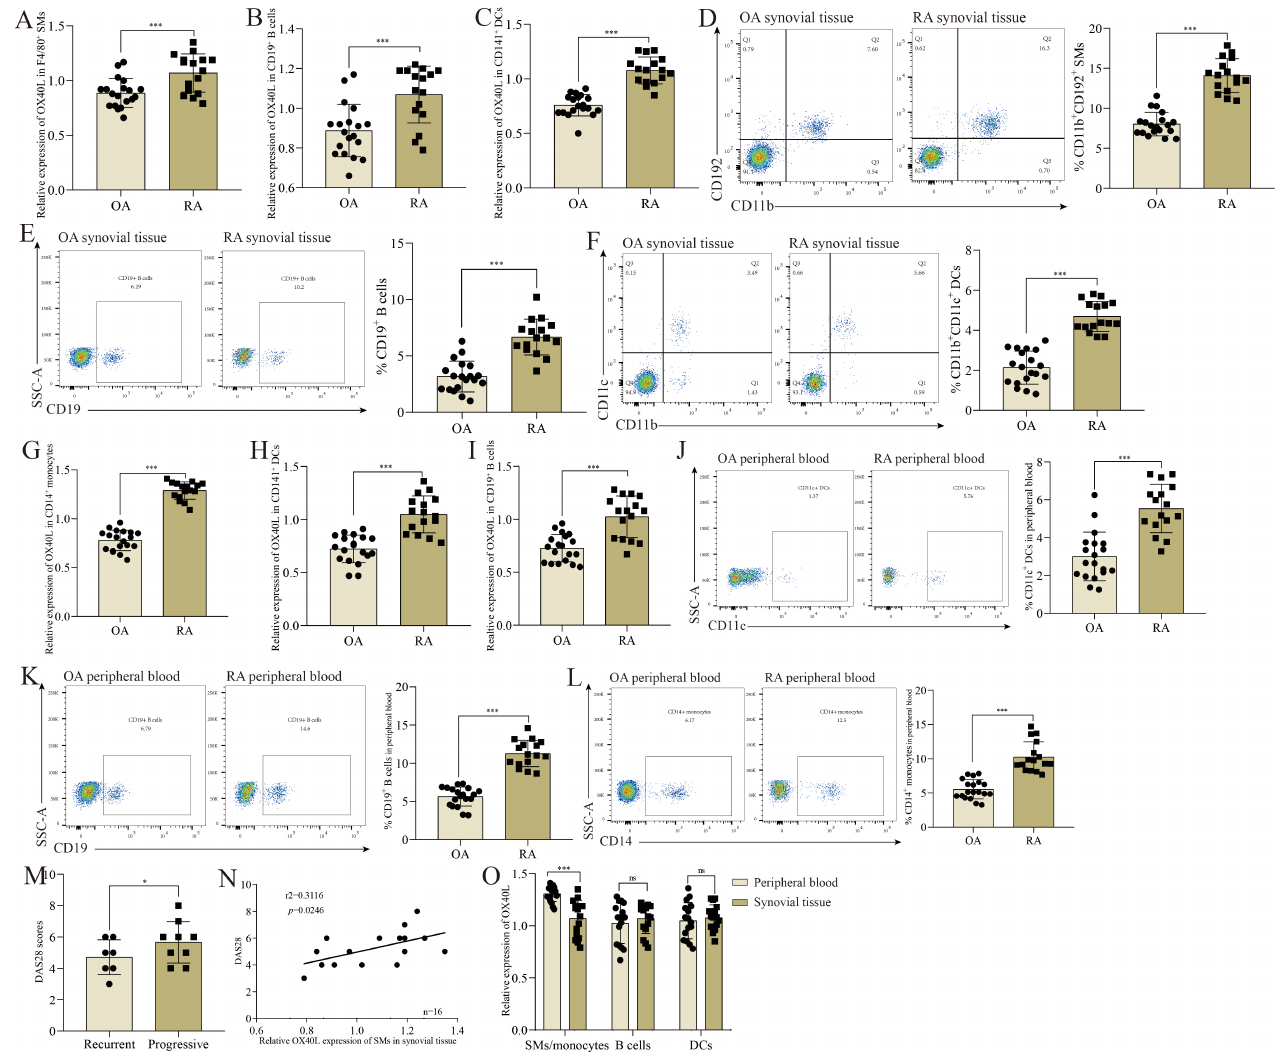
Figure 1. OX40L is up-regulated in antigen-presenting cells in the synovial tissues of RA patients, and the OX40L level in CD11b + CD192 + SMs is positively correlated with DAS28. ( A ) RT-qPCR analysis of the relative expression of OX40L in F4/80 + SMs sorted from synovial tissue. ( B ) RT-qPCR analysis of the relative expression of OX40L in CD19 + B cells sorted from synovial tissue. ( C ) RT-qPCR analysis of the relative expression of OX40L in CD141 + DCs sorted from synovial tissue. ( D ) Frequency of CD11b + CD192 + SMs in the synovial tissues of the patients with RA and the patients with OA. ( E ) Frequency of CD19 + B cells in the synovial tissues of the patients with RA and the patients with OA. ( F ) Frequency of CD11b + CD11c + DCs in the synovial tissues of the patients with RA and the patients with OA. ( G ) RT-qPCR analysis of the relative expression of OX40L in CD14 + monocytes sorted from peripheral blood. ( H ) RT-qPCR analysis of the relative expression of OX40L in CD141 + DCs sorted from peripheral blood. ( I ) RT-qPCR analysis of the relative expression of OX40L in CD19 + B cells sorted from peripheral blood. ( J ) Frequency of CD11c + DCs in the peripheral blood of RA patients and OA patients. ( K ) Frequency of CD19 + B cells in the peripheral blood of the patients with RA and the patients with OA. ( L ) Frequency of CD14 + monocytes in the peripheral blood of the patients with RA and the patients with OA. ( M ) DAS28 score for RA patients. ( N ) Correlation analysis of OX40L level of SMs in the synovial tissues with DAS28 in RA patients. ( O ) Comparison of OX40L level in the three cell types (SMs/monocytes, B cells, and DCs) in the synovial tissues and peripheral blood. In ( A – L ), *** p < 0.001 represent a significant difference between the RA group and the OA group. In ( M ), * p < 0.05 represents a significant difference